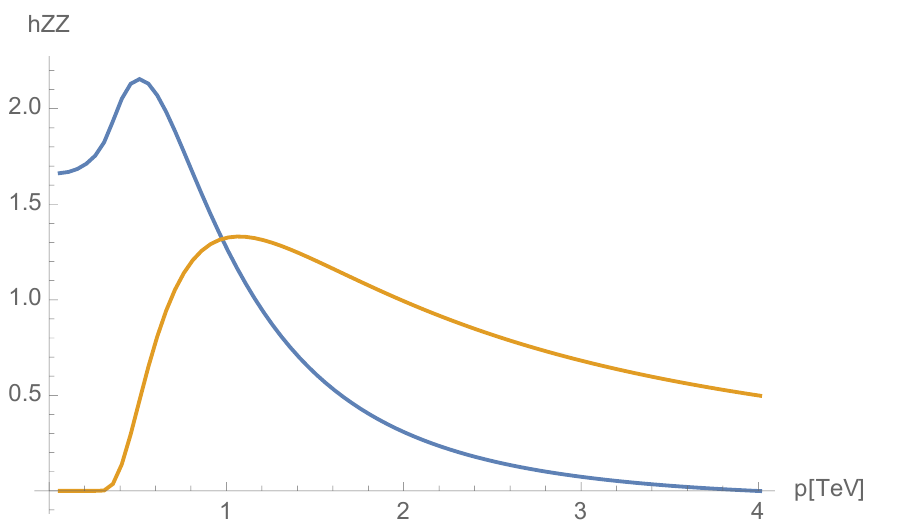
Figure 4. Real (blue) and imaginary (Orange) part of the hZZ form factor, with (cid:22) = 0 : 2 TeV, (cid:23) = 0 : 3. The imaginary part is only non-zero for p > (cid:22)